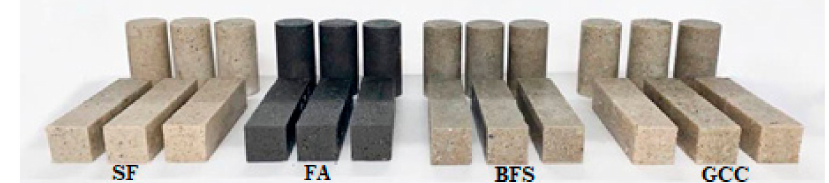
Figure 3. Specimen shape, depending on the type of filler; silica flour (SF), fly ash (FA), blast furnace slag (BFS), and ground calcium carbonate